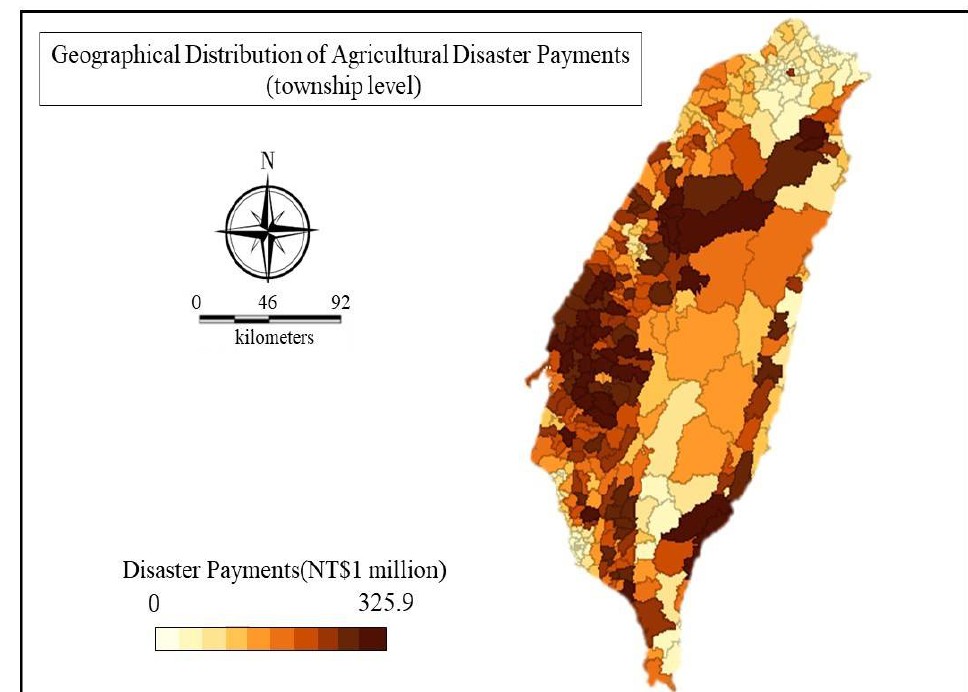
Figure 1. Geographical distribution of agricultural disaster payments (township level). Note: The agricultural disaster payments assigned to each township are the cumulative values between July 2012 and October 2015. There are 368 townships in Taiwan in total. The grey areas are those townships without any disaster shocks (57 townships). For the areas with marked colors (311 townships), darker colored townships are those with higher disaster payments, while those with lighter colors have lower disaster payments.